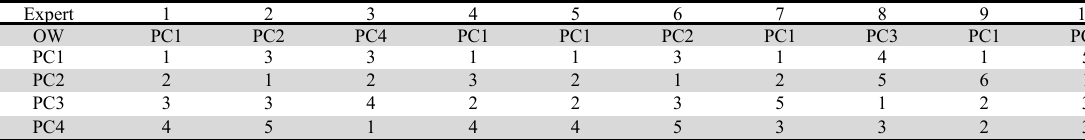
Process challenge preferences (Others to worst)